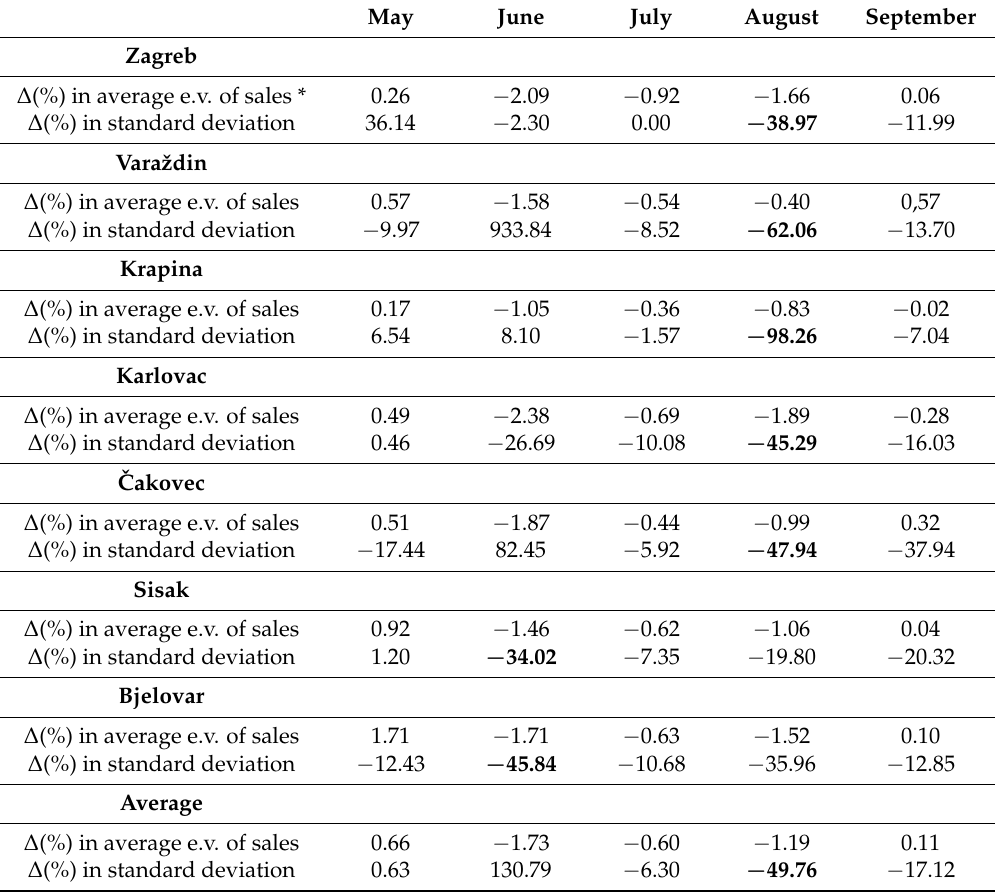
Table 4. Performance of temperature put options, by city and contract